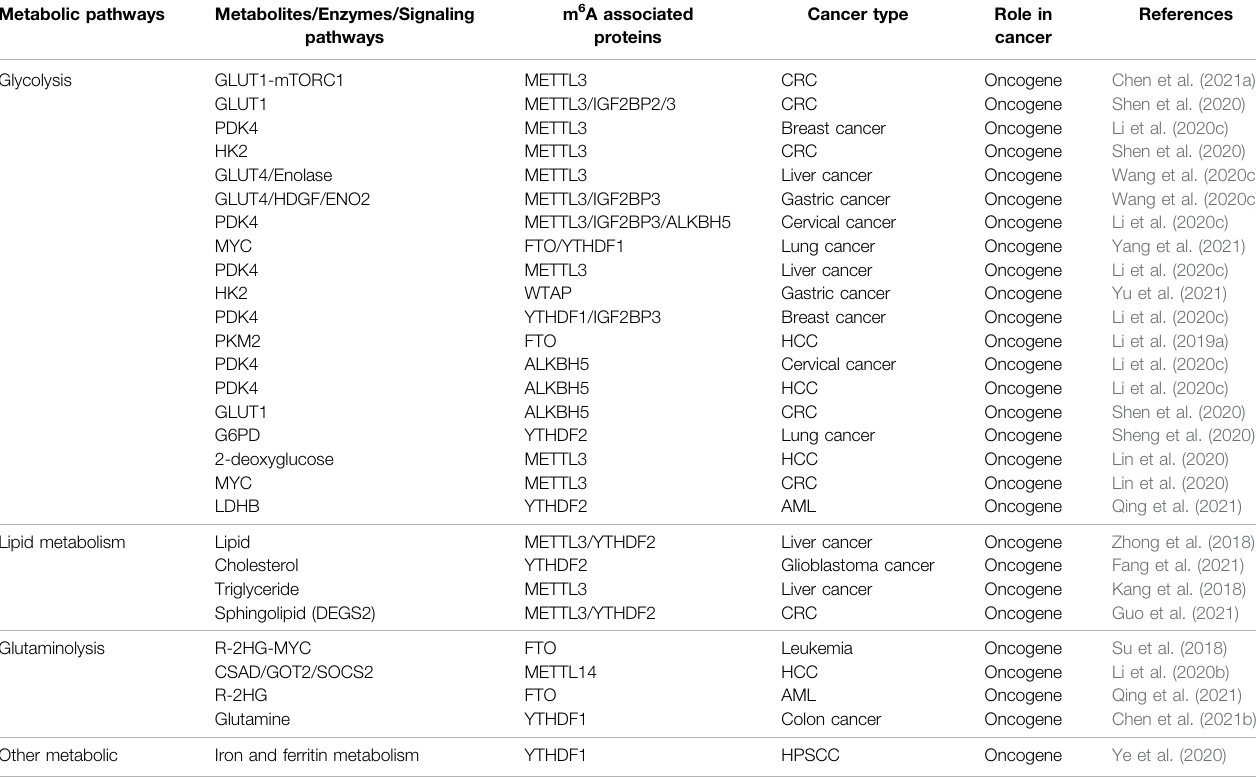
TABLE 1 | Regulation of metabolites by m 6 A associated proteins in cancer. Metabolic